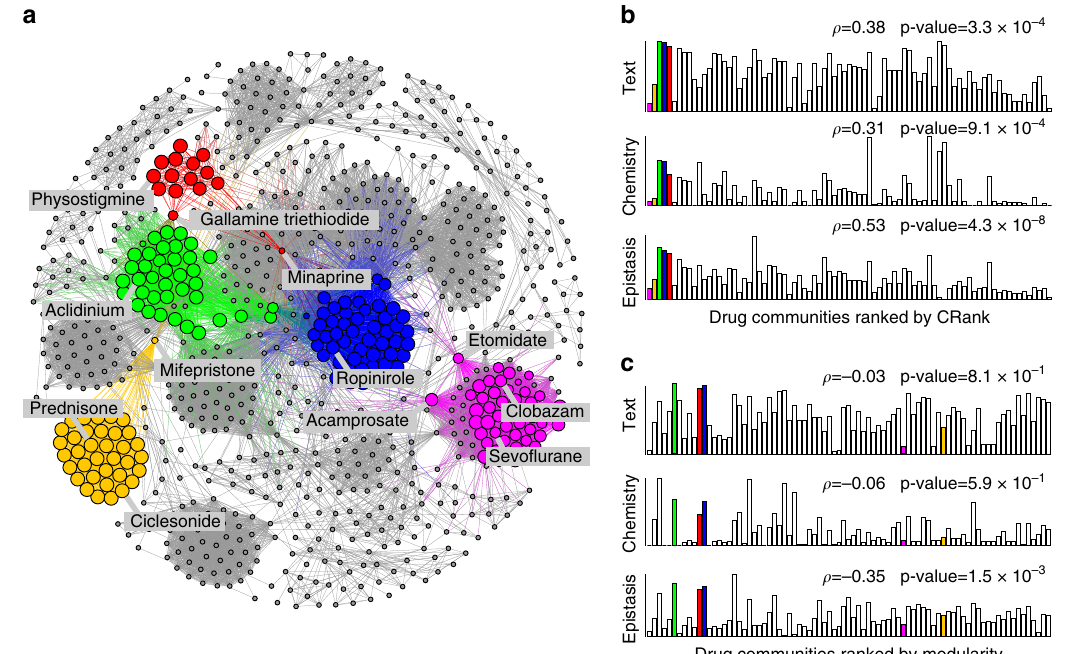
Fig. 3 Prioritizing network communities in the network of medical drugs. a The network of medical drugs connects two drugs if they share at least one target protein. Communities were detected by a community detection method 7 , and then prioritized by CR ANK . Highlighted are fi ve highest-ranked communities as determined by CR ANK . Nodes of the highlighted communities are sized by their score of the Likelihood prioritization metric (Supplementary Note 3). Investigation reveals that these communities contain drugs used to: treat asthma and allergies (e.g., prednisone, ciclesonide; yellow nodes), induce anesthesia or sedation (e.g., clobazam, etomidate, sevo fl urane, acamprosate; magenta nodes), block neurotransmitters in central and peripheral nervous systems (e.g., physostigmine, minaprine, gallamine triethiodide; red nodes), block the activity of muscarinic receptors (e.g., acidinium; green nodes), and activate dopamine receptors (e.g., ropinirole; blue nodes). b , c We evaluate community prioritization against three external chemical databases (Supplementary Note 6) that were not used during community detection or prioritization. For each community we measure: (1) drug-drug interactions between the drugs ( “ Epistasis ” ), (2) chemical structure similarity of the drugs ( “ Chemistry ” ), and (3) associations between drugs derived from text data ( “ Text ” ). We expect that a true high-priority community will have more drug-drug interactions, higher similarity of chemical structure, and stronger textual associations between the drugs it contains. Taking this into consideration, the external chemical databases de fi ne three gold standard rankings of communities against which CR ANK is evaluated. Bars represent communities; bar height denotes similarity of drugs in a community with regard to the gold standard based on external chemical databases. In a perfect prioritization, bars would be ordered such that the heights would decrease from left to right. b CR ANK ranking of drug communities outperforms ranking by modularity c across all three chemical databases (as measured by Spearman ’ s rank correlation ρ with the gold standard ranking). CR ANK ranking achieves ρ = 0.38, 0.31, 0.53, while modularity obtains ρ = − 0.03, − 0.06, −